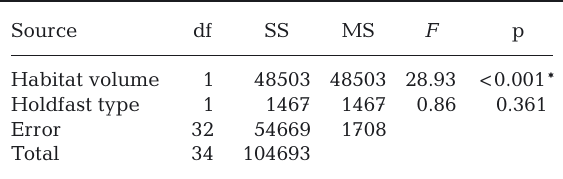
sown in January were more species-rich than hold- their smaller volume.